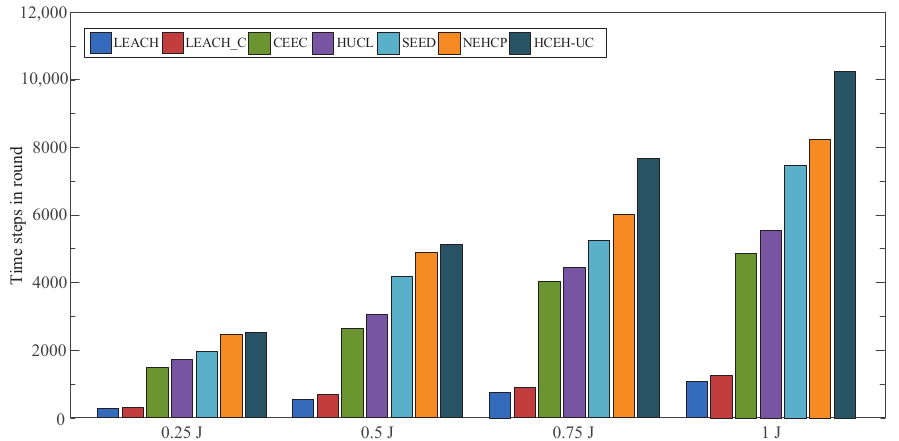
Figure 5. MLC of different routing protocols under various energy